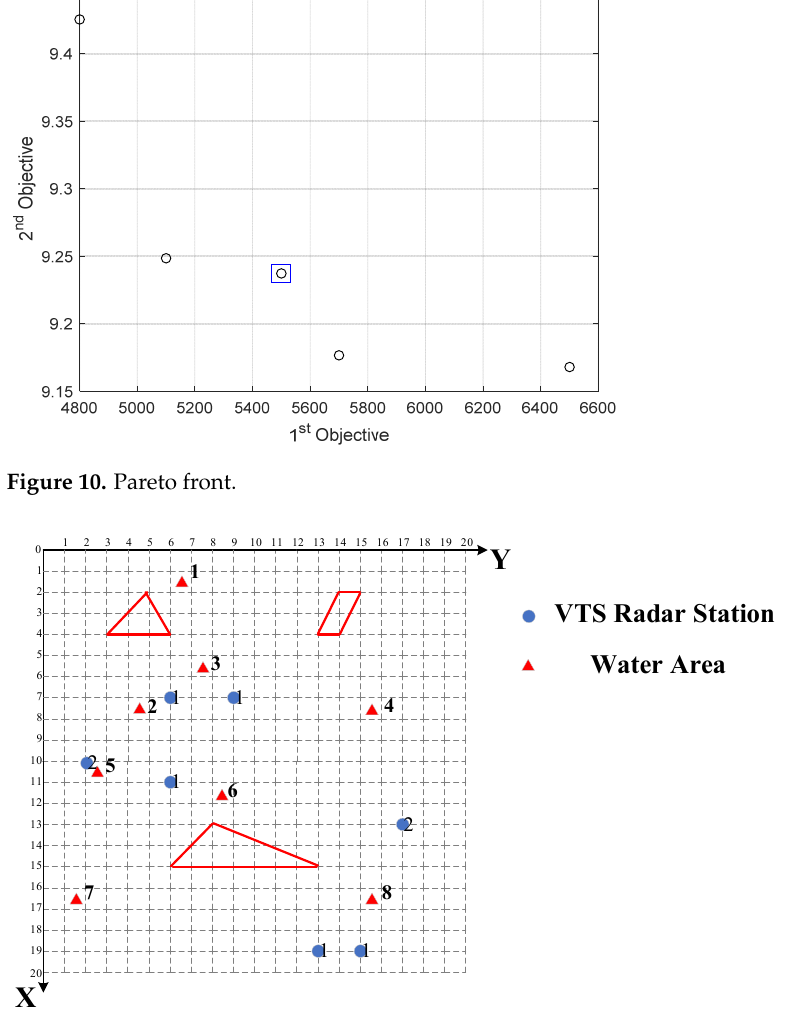
Figure 11. Distribution map of VTS radar station to be built.